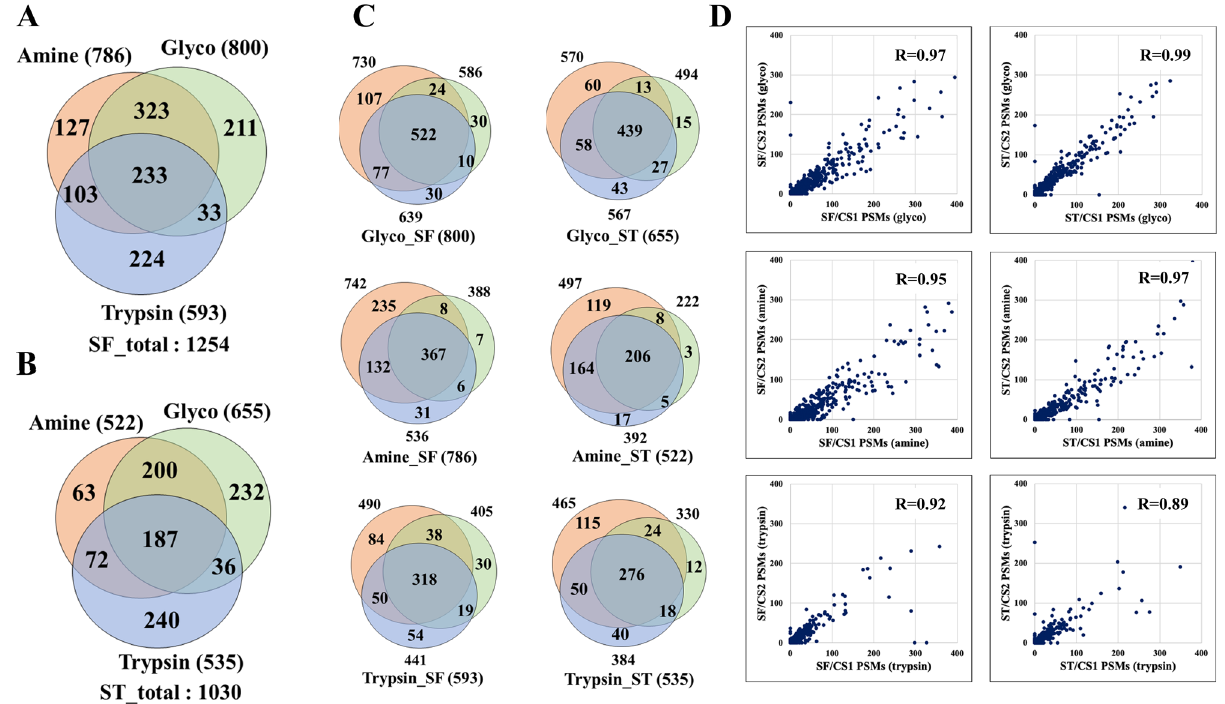
Figure 3. Protein ID Venn and PSM correlation diagrams representing the complementarity and reproducibility of the three labeling methods in detecting cell-membrane proteins matched by at least 2 unique peptides ( FDR < 3%). ( A ) Serum-free cultured cells. ( B ) Serum-treated cells. ( C ) Reproducibility of protein detection between three biological replicates for each labeling method and cell treatment condition (SF and ST). ( D ) PSM correlations between any two biological replicates for each of the three cell-membrane protein enrichment methods; the correlations are shown for the 0–400 PSM range in which the vast majority of proteins could be found (R = Pearson correlation